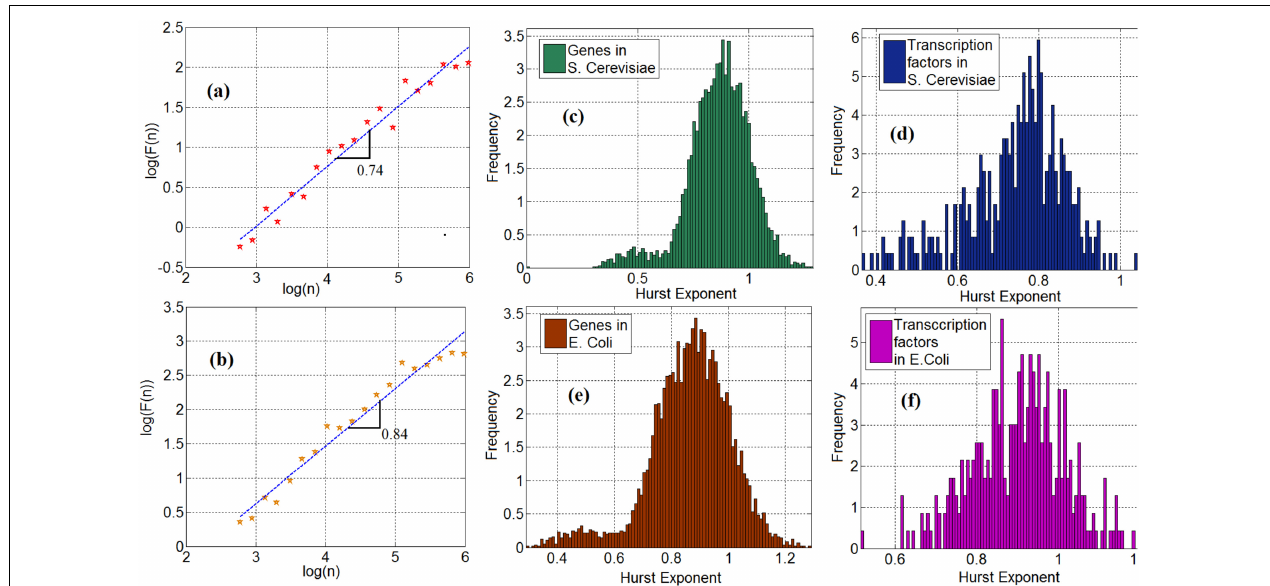
FIGURE 2 | (a) Scaling of fluctuation function of a gene time series in Saccharomyces cerevisiae , (b) Scaling of fluctuation function of ynel gene time series in E. coli , (c) Histogram of cross-correlation exponent of genes in S. cerevisiae , (d) Histogram of cross-correlation exponent of TFs in S. cerevisiae , (e) Histogram of cross-correlation exponent of genes in E. coli . (f) Histogram of cross-correlation exponent of TFs in E. coli .